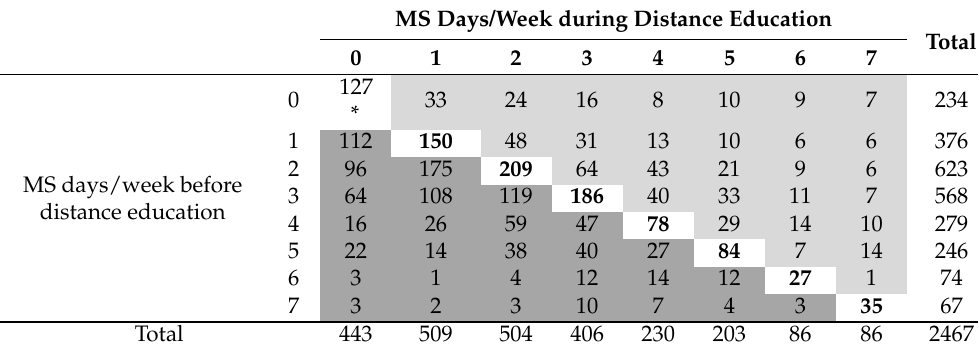
Table 3. Shift table for the level of muscle strengthening (MS) before and during distance education. MS Days/Week during Distance